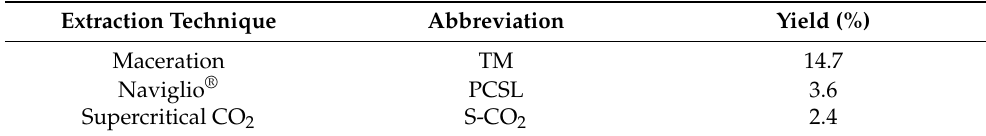
Table 1. Prangos ferulacea Lindl.